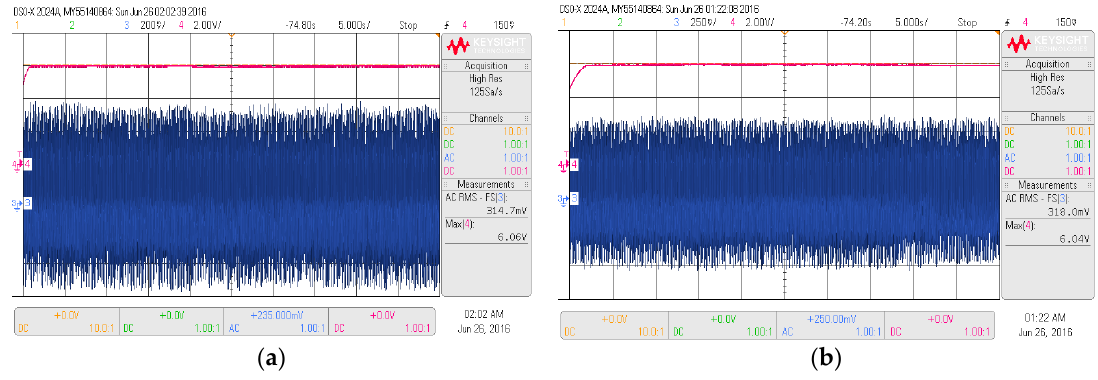
Figure 15. Experimental results of a complete PEHS utilizing a BSA-PI ( a ) and a PSO-PI ( b ) controller. Table 7. Comparison of the output voltage.